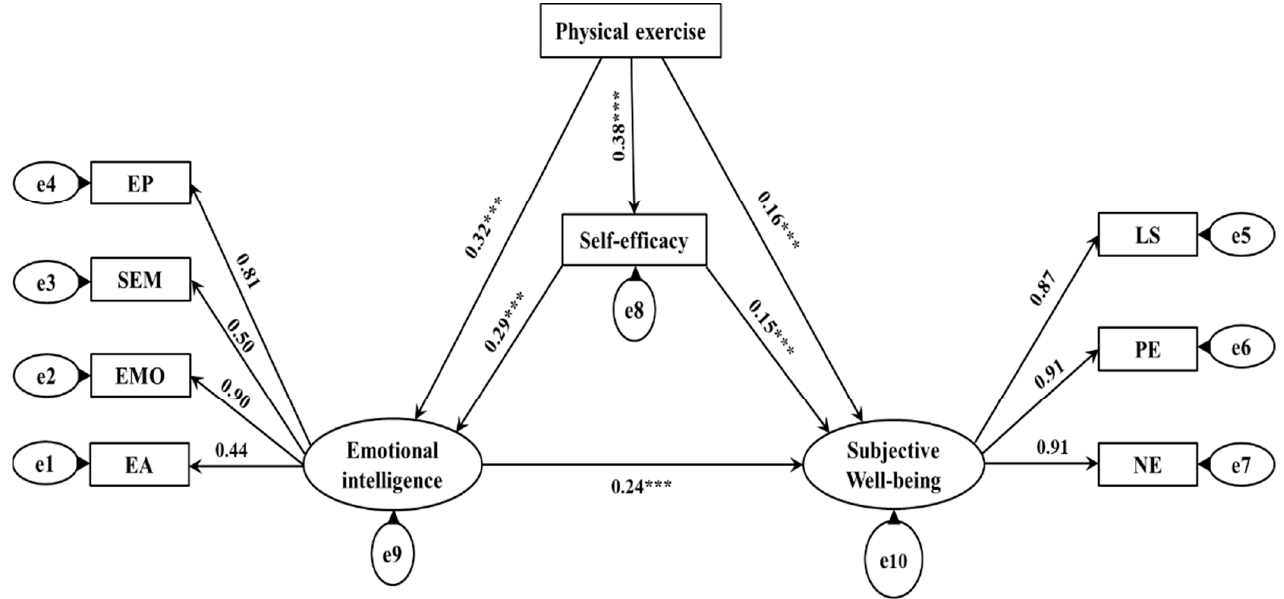
Figure 1. The chain mediation model of self-efficacy and emotional intelligence between physical exercise and subjective well-being. *** p < 0.001. Table 3. Decomposition of the effect of physical exercise on subjective well-being.